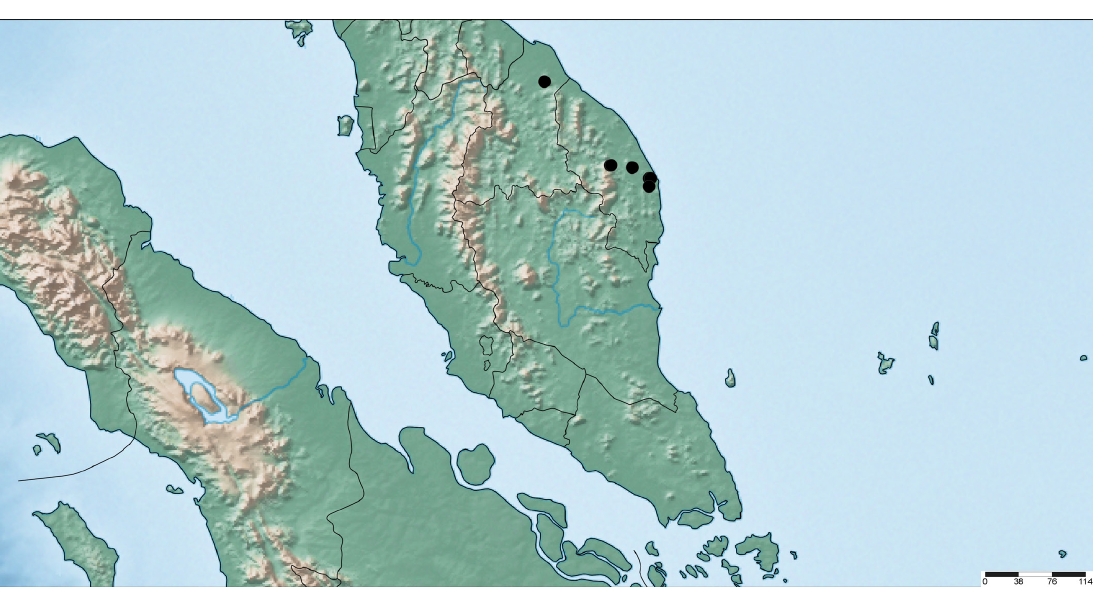
Fig. 2. Map showing the collecting localities of Polyalthia pakdin I.M.Turner & Utteridge sp.